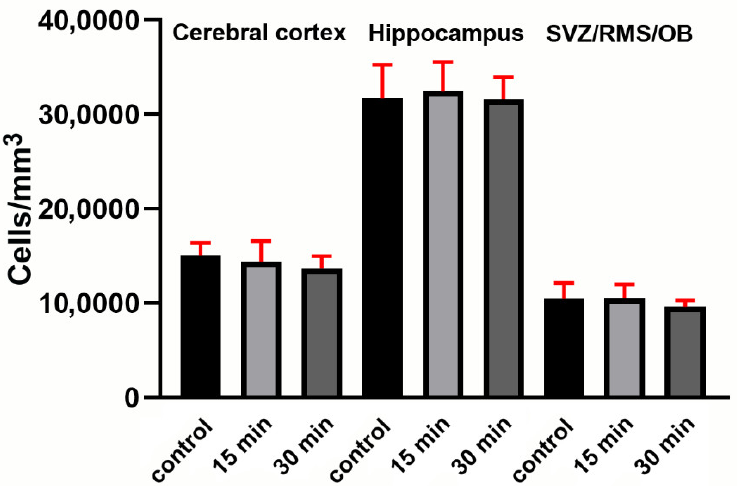
Figure A4. Volumetric cellular density in the cerebral cortex, hippocampus, and SVZ/RMS/OB after nuclear labeling with DAPI. To reduce errors, we cleaned data by removing outliers (ROUT, Q = 1%). Six outliers have been removed in total (2 in cerebral cortex controls, 2 in SVZ/RMS/OB controls, 2 in SVZ/RMS/OB 15 min). Data are expressed as mean ± 95% CI. Bars are 95% CI.